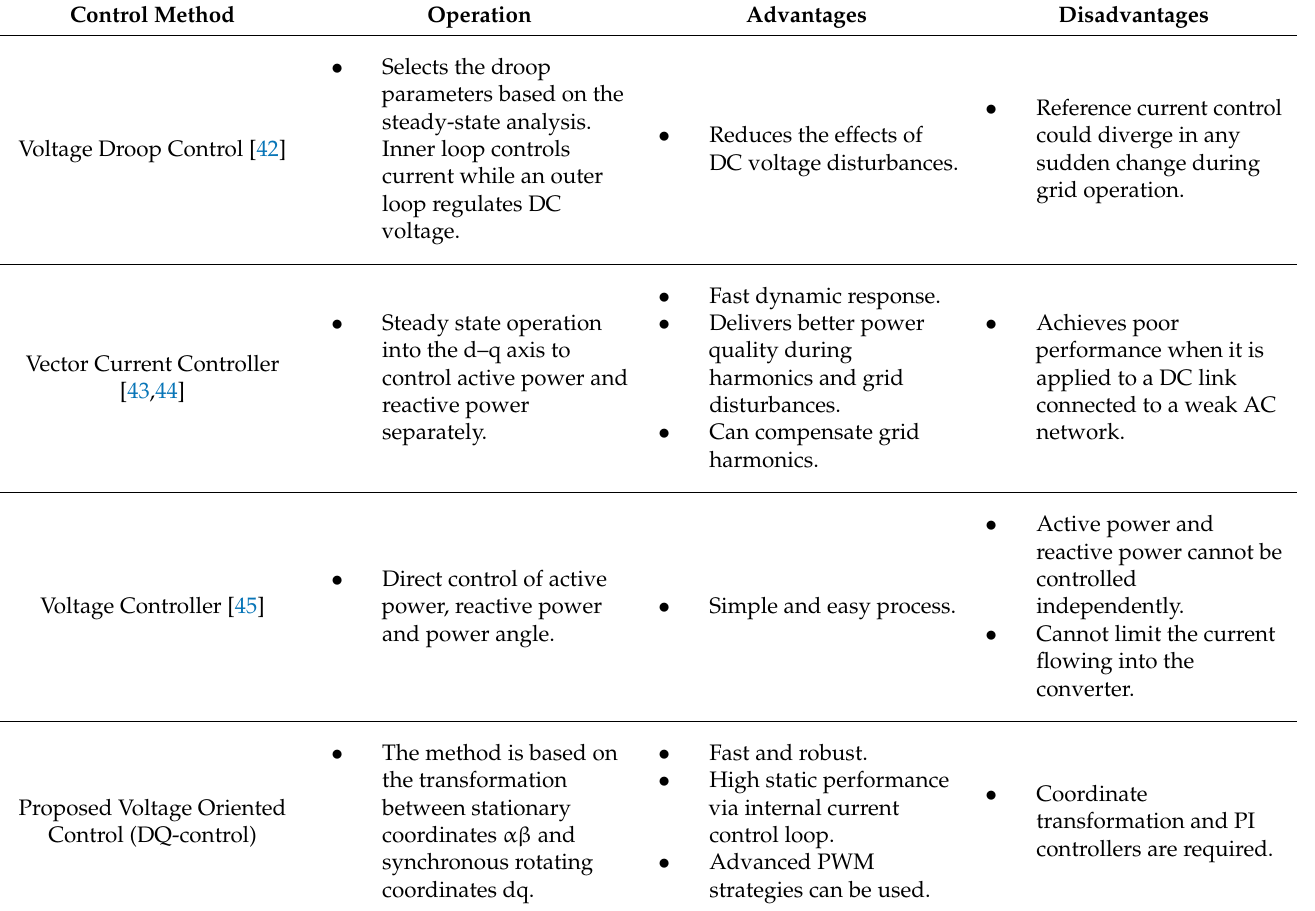
Figure 2. Typical radial DC microgrid configuration. The PV based microgrid is controlled through a MPPT controller, a BESS local control unit that charge-discharges the battery bank based on the operation mode and a VSC controller. Table 1 introduces comparative analysis of various VSC control strategies. Table 1. Comparative Analysis of VSC control strategies.